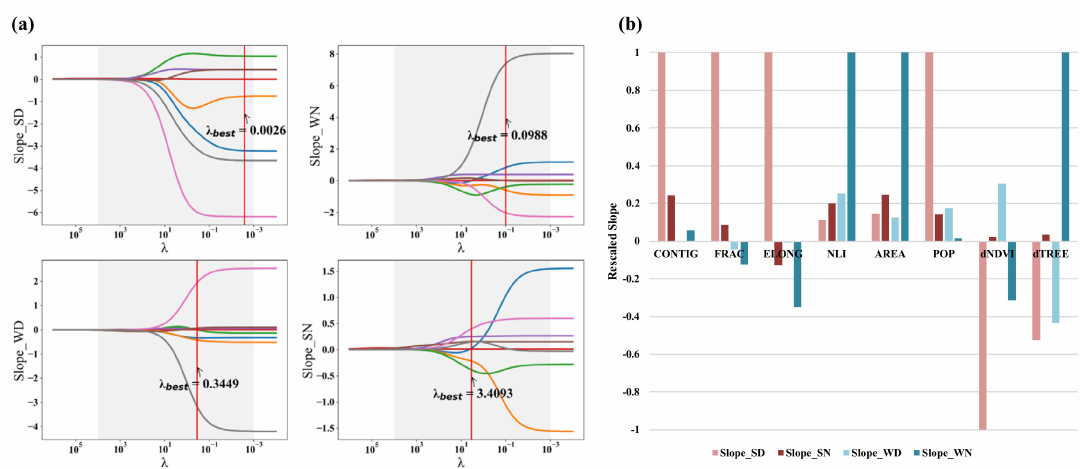
Figure 6. Ridge trace distribution map and the rescaled coe ffi cient histogram. ( a ) is the ridge trace map obtained by ridge regression, with the gray background representing the GCV search span and the red line representing the obtained best parameter ( λ ). Each line of a di ff erent color represents the coe ffi cient of one UFI. ( b ) shows the relative magnitude of impact for each UFI across the di ff erent seasons and between day and night, with the vertical axis representing the rescaled slope